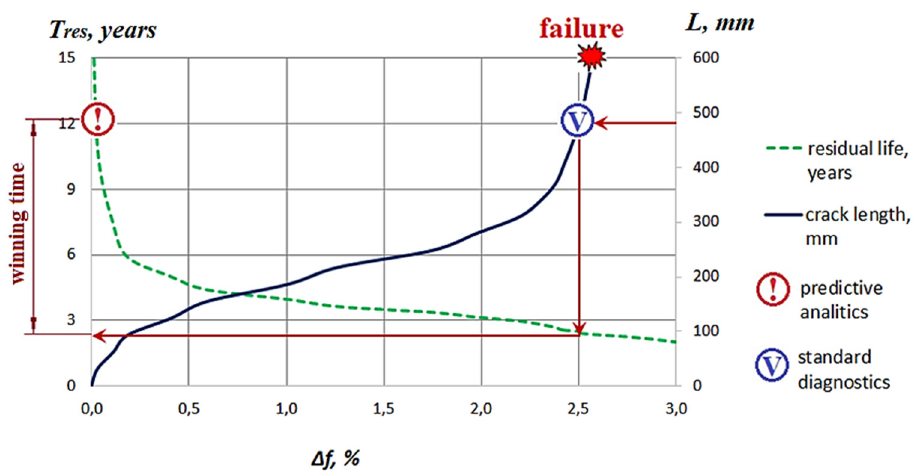
Figure 6. Comparison of the capabilities of analytical and vibrodiagnostic methods for detecting cracks in the Francis turbine runner.